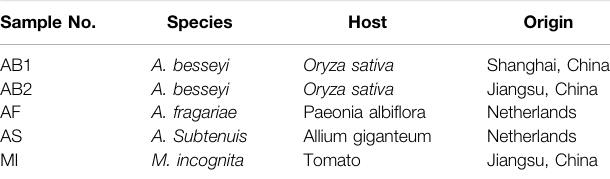
TABLE 1 | Plant-parasitic nematode species used in this study. Sample No.